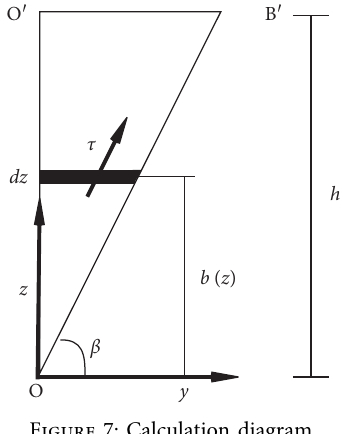
Figure 7: Calculation